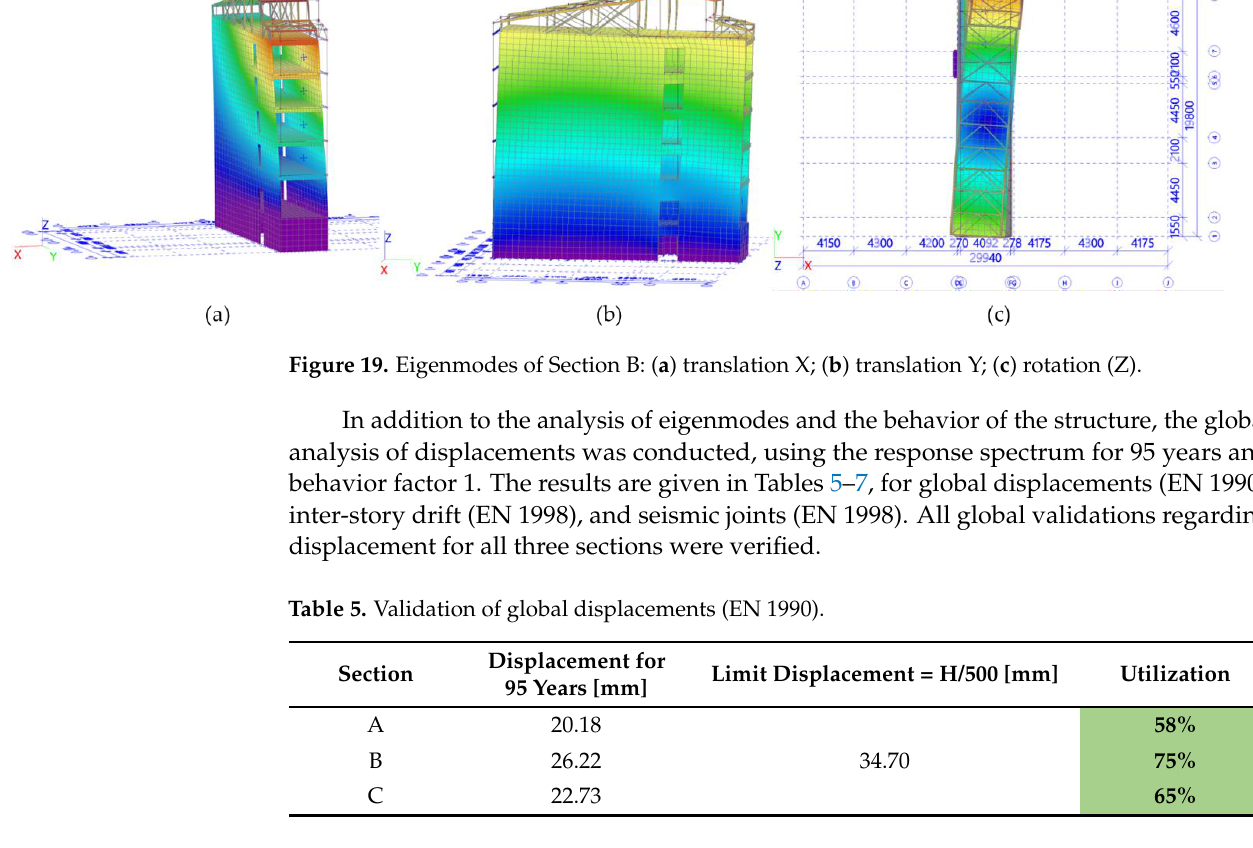
Figure 18. Eigenmodes of Section A: ( a ) translation X; ( b ) translation Y; ( c ) rotation (Z).